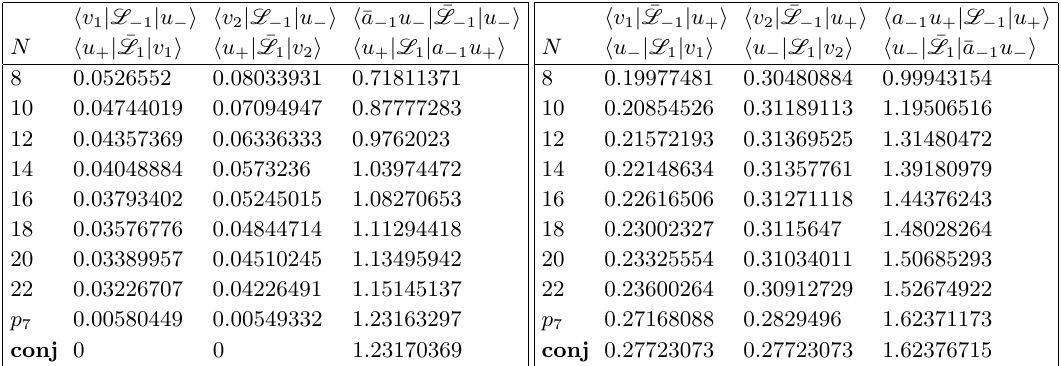
Table 3 . Matrix elements of L (cid:6) 1 and (cid:22) L (cid:6) 1 in the sector of S z = 1, at x = (cid:25) . We call j u (cid:0) i the primary state at e = (cid:0) 1 and j u + i the primary state at e = 1 (both in the N ! 1 limit), with charges given by (3.34). j v 1 i and j v 2 i are linear combinations of j a (cid:0) 1 u (cid:0) i and j (cid:22) a (cid:0) 1 u + i containing equal parts of both states, as discussed in section 4.1.1. We here denote the corresponding scaling states on the lattice by the same labels as the states in the limits. The matrix elements are computed at increasing lattice size N , after which polynomial extrapolations p n (1 =N ) of degree n = 7 to all the data points is made in order to approximate the value at N ! 1 . The CFT value (\conj") p h a (cid:0) 1 u j L (cid:0) 1 u i for a primary state u with charge (cid:11) is 2 (cid:11) , as described in section 5.2. Due to j v 1 i ; j v 2 i being mixed states, the nonzero matrix elements involving these states are conjectured to come with a factor of 1 p : while the full value is 0.39206346 ( (cid:11) = 2 (cid:11) 0 ) we here instead conjecture 2 a value of 0.27723073